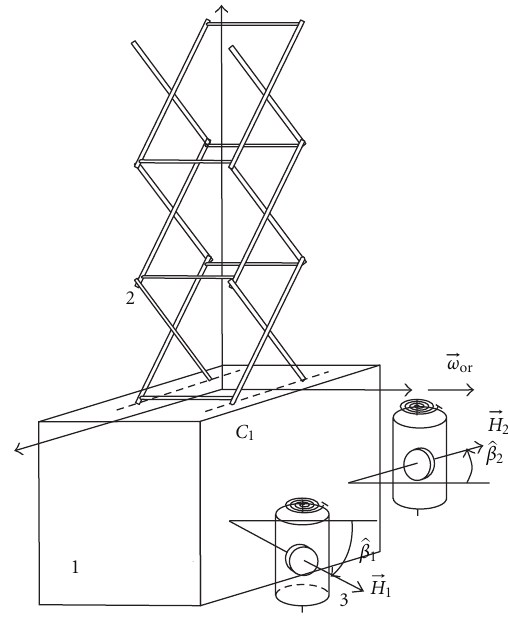
Figure 1: Basic elements of the